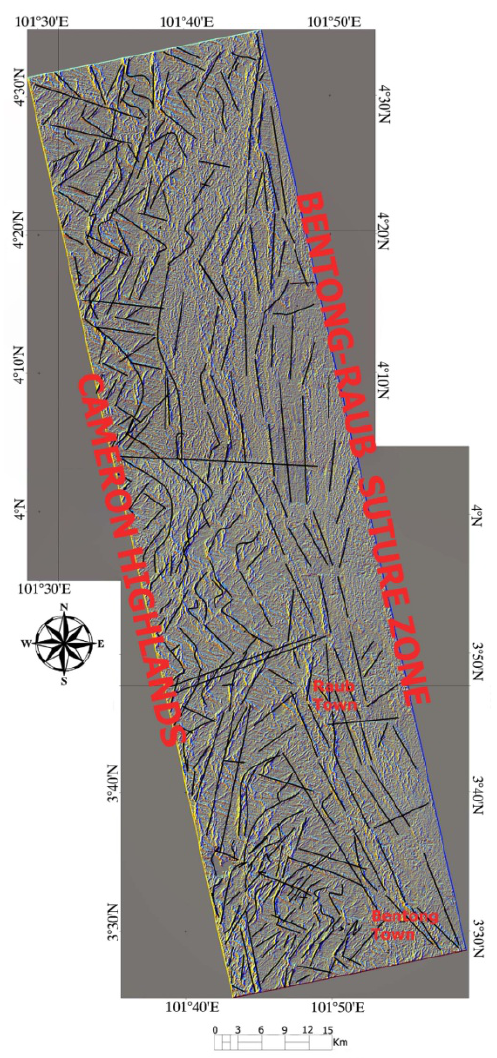
Fig.3. RGB image of N- S (0◦), NE - SW (45◦), and NW -SE (135◦) directional filters, southeastern part of the Bentong -Raub Suture